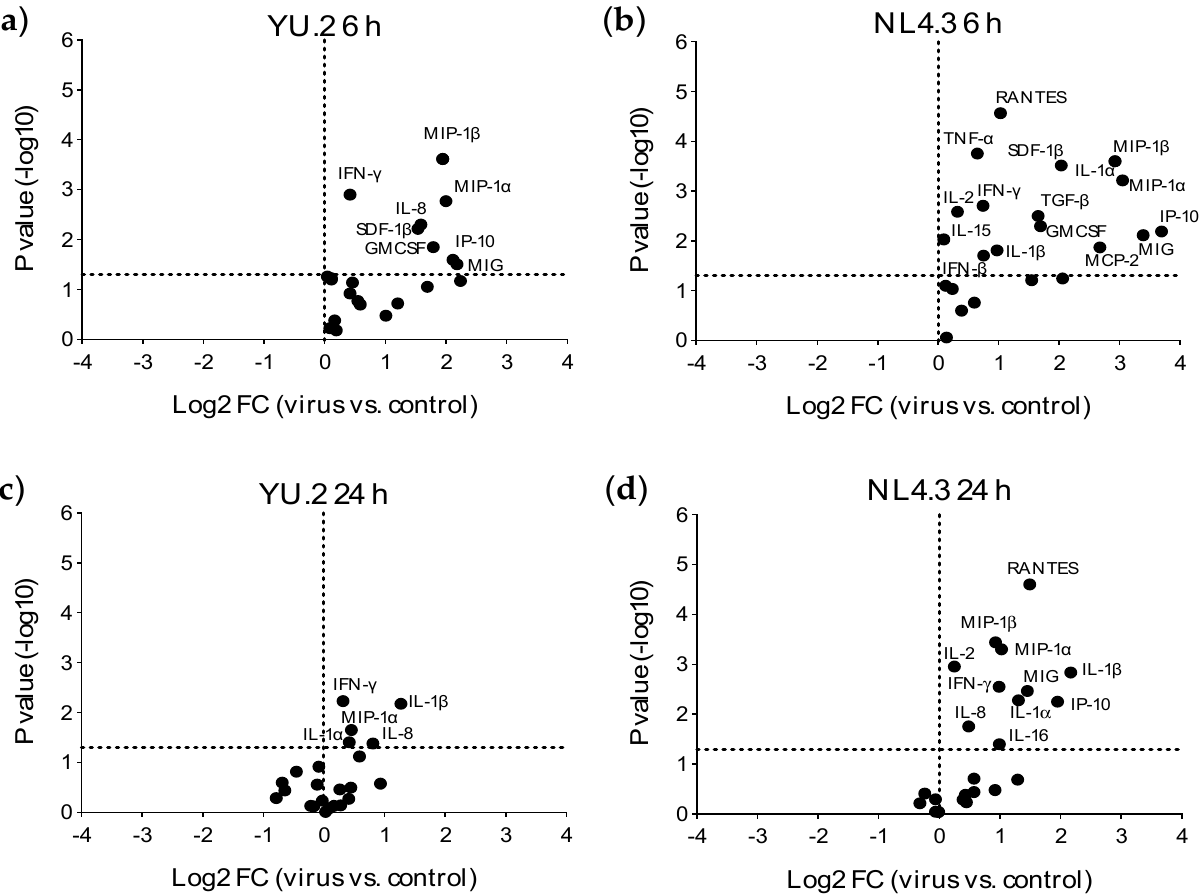
Figure 3. Modulation of colorectal cytokine profile induced by exposure to HIV-1. Volcano plots of all cytokines measured after 6 ( a , b ) or 24 h ( c , d ) of culture and comparing colorectal explants exposed to YU.2 ( a , c ) or NL4.3 ( b , d ) to those unchallenged (control). FC: fold change. Horizontal dotted line indicates a p value of 0.05. Analytes above this line are significantly modulated. Vertical dotted line is set at a Log 2 FC = 0. Data shown are from four independent experiments performed with tissue from different donors.